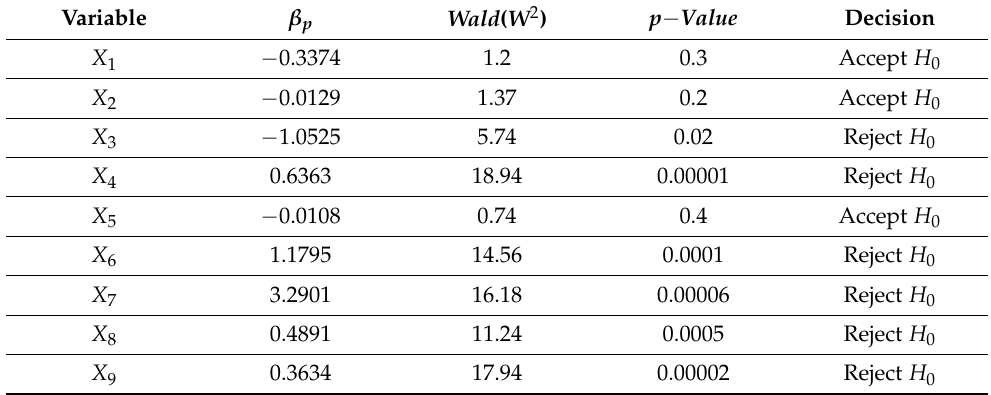
Table 10. Partial significance test results with Wald